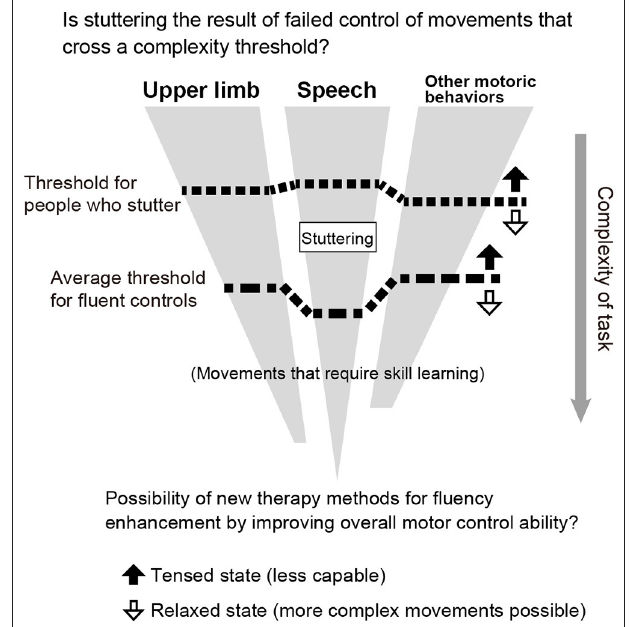
FIGURE 5 | Relationship between stuttering and threshold of motor control ability